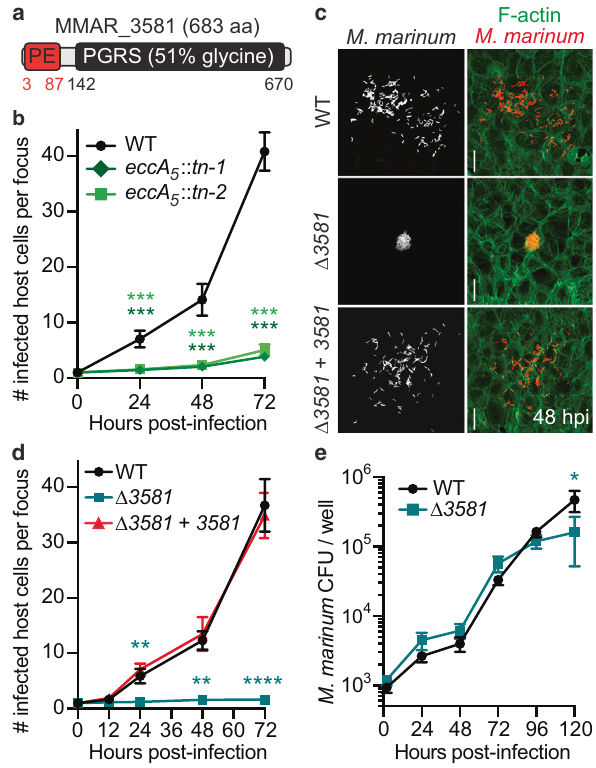
Fig. 1 MMAR_3581 , an ESX-5-secreted substrate, is necessary for M. marinum cell-to-cell spread. a Domain structure of the PE_PGRS protein MMAR_3581. b Time course graph indicating the number of host U2OS cells in an infectious focus during infection of M. marinum wild type or eccA 5 transposon inserted strains. c Micrographs depicting bacterial cell-to-cell spread within a host cell monolayer in a single infectious focus with speci fi ed M. marinum (red; tdTomato) strains in U2OS host cells (green; Alexa 488 phalloidin) at 48 hpi. Scale bar is 10 µ m and images are representative of three independent experiments. d Time course graph indicating the number of host U2OS cells per infectious focus during infection of indicated M. marinum strains. e Growth curve of indicated M. marinum strains during infection of U2OS host cells. For b , d , e data is mean± SD; n = 3 independent experiments. Data in b , d used a one-way ANOVA with post-hoc Tukey